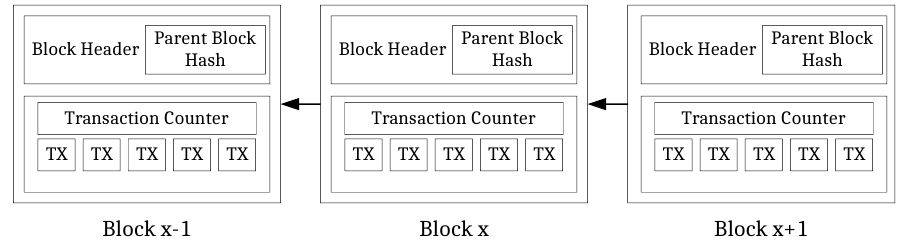
Figure 1. General blockchain structure—based on